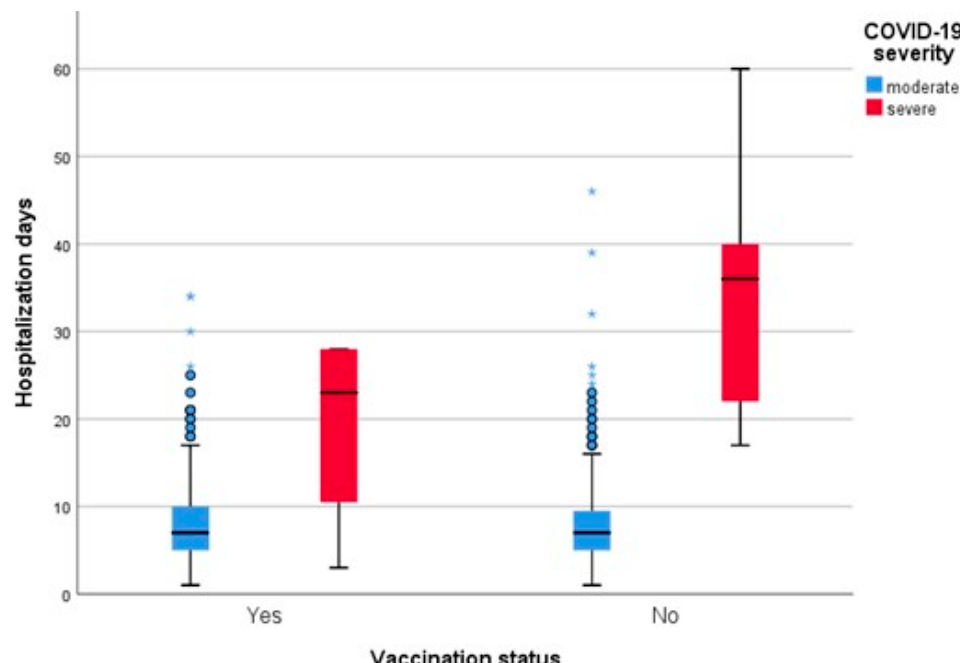
Figure 3. Length of hospitalization grouped by vaccination status and adjusted by clinical severity.